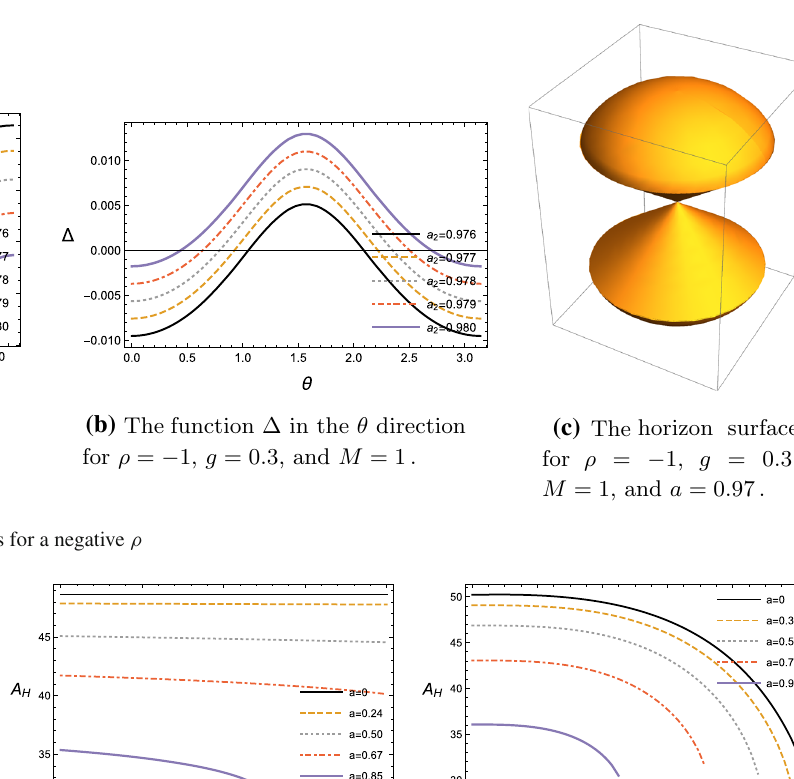
area for ρ = 1 and g = 0 . 3. Fig. 7 The area of the outer horizon of the rotating Hayward black hole